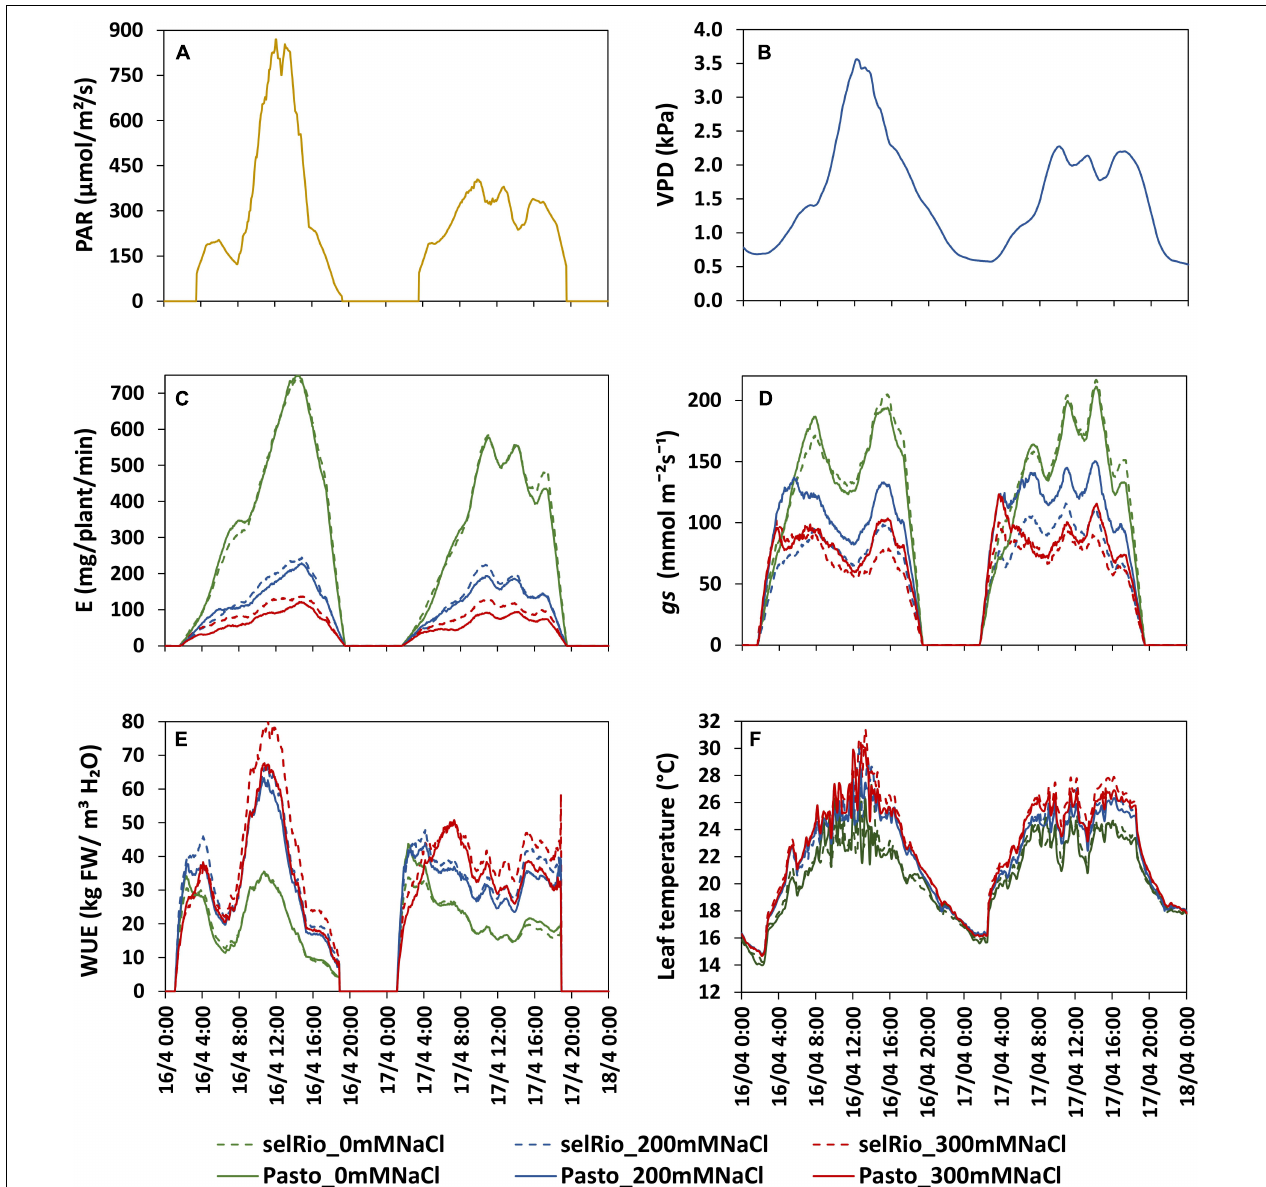
FIGURE 6 | Daily patterns of experimental conditions measured by sensors and physiological components derived from Plantarray measurements. The influence of a bright (16/4/2019, 62 DAS, 41 days after the start of the stress) and cloudy day (17/4/2019, 63 DAS, 42 days after the start of the stress) are compared. (A) Light intensity. (B) VPD. (C) Transpiration rate (E). (D) Stomatal conductance ( gs ). (E) Water use efficiency (WUE). (F) Leaf temperature measured by a thermal